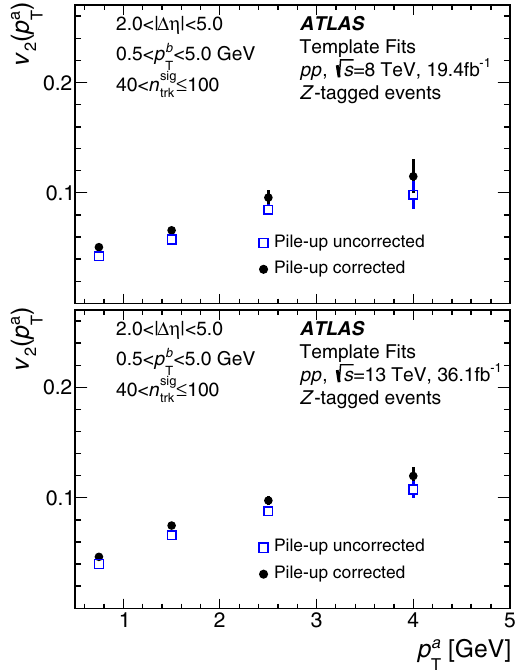
≤ 100. The top right panel shows the uncorrected 2PCs for 40 < n sig trk ratio of the uncorrected v 2 to the corrected v 2 . The error bars indicate statistical uncertainties and are not shown in the ratio plots. The lower trk panels show similar plots for the 13 TeV